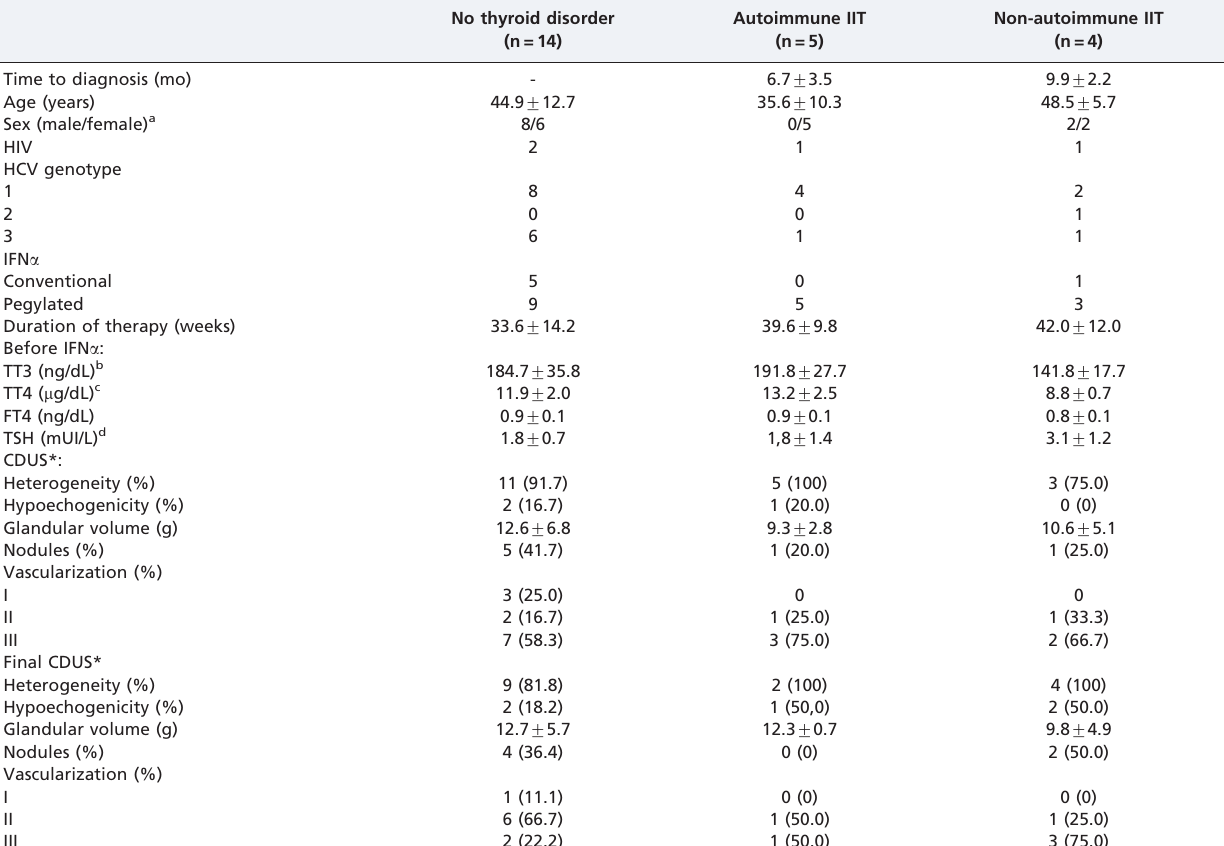
Table 1 - The characteristics of the subjects with autoimmune and non-autoimmune interferon-induced thyroiditis and the subjects with no thyroid disorders during interferon-alpha and ribavirin therapy.